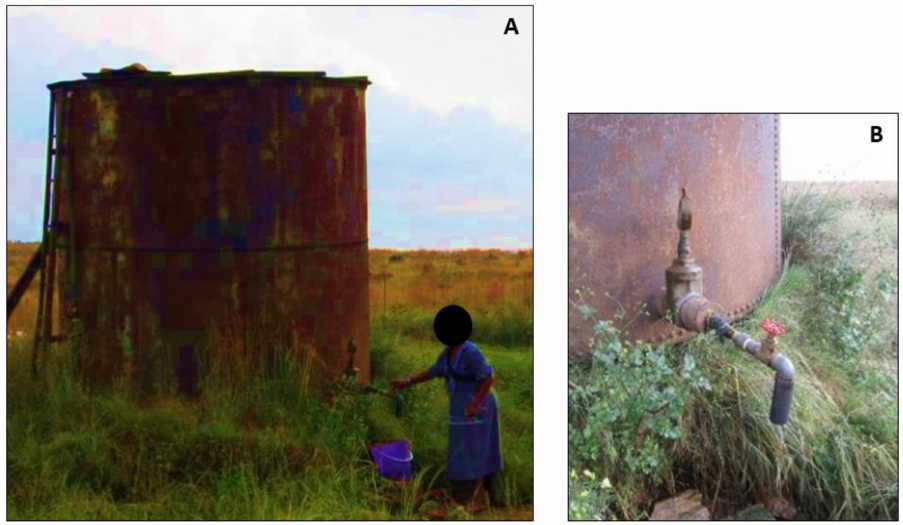
Figure 1. Central, large water storage tank ( A ), with close-up photo of tap ( B